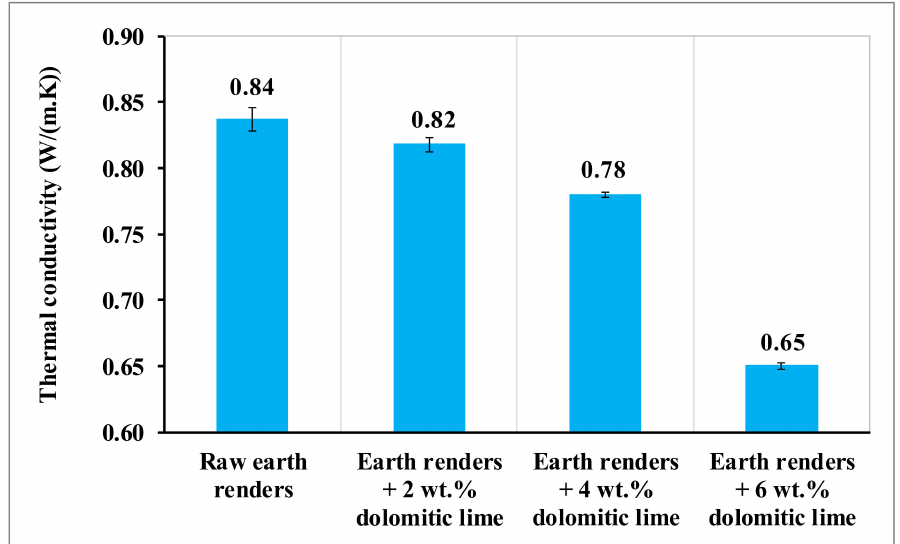
Figure 11. Thermal conductivity of earth renders with dolomitic lime